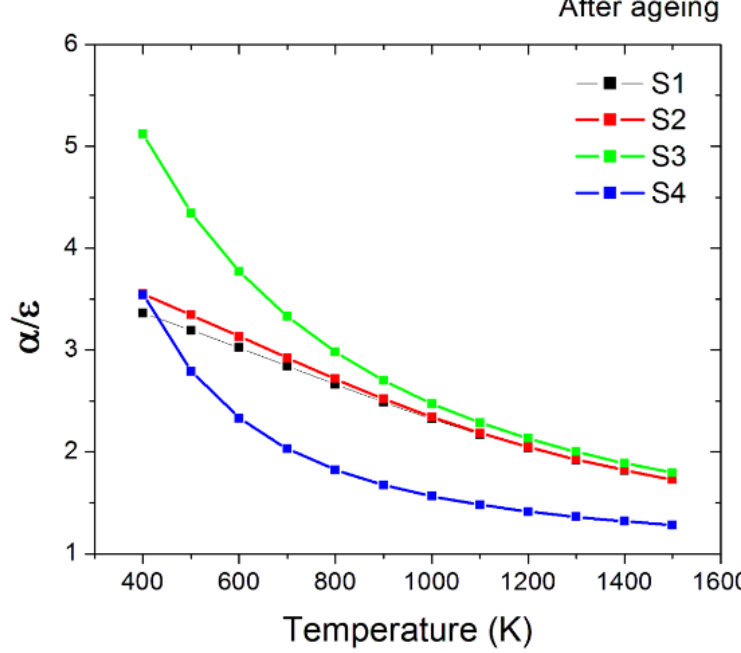
Figure 18. Spectral selectivity ( α / ε ratio) of the four nanotextured samples compared to the untreated material in the function of temperature after the thermal annealing process.